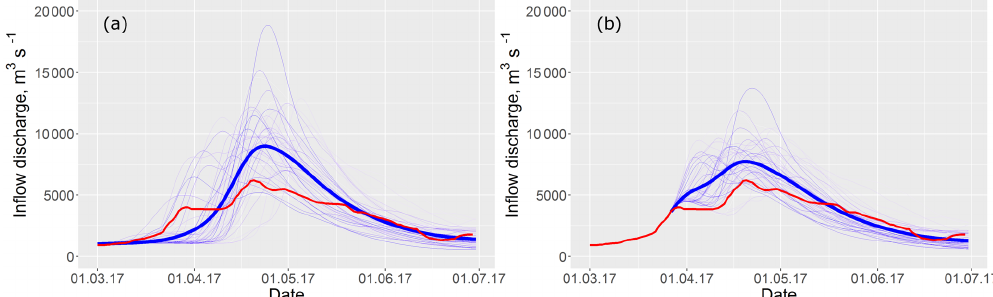
Figure 6. The ESP-based forecast of daily inflow discharge for the period from 1 April till 30 June 2017 issued on 1 March (a) and 27 March (b) . The thin blue lines represent the ensemble of the forecasted hydrographs, the bold blue line represents the mean ensemble hydrograph and the red line represents the observed hydrograph of inflow into the Cheboksary Reservoir.